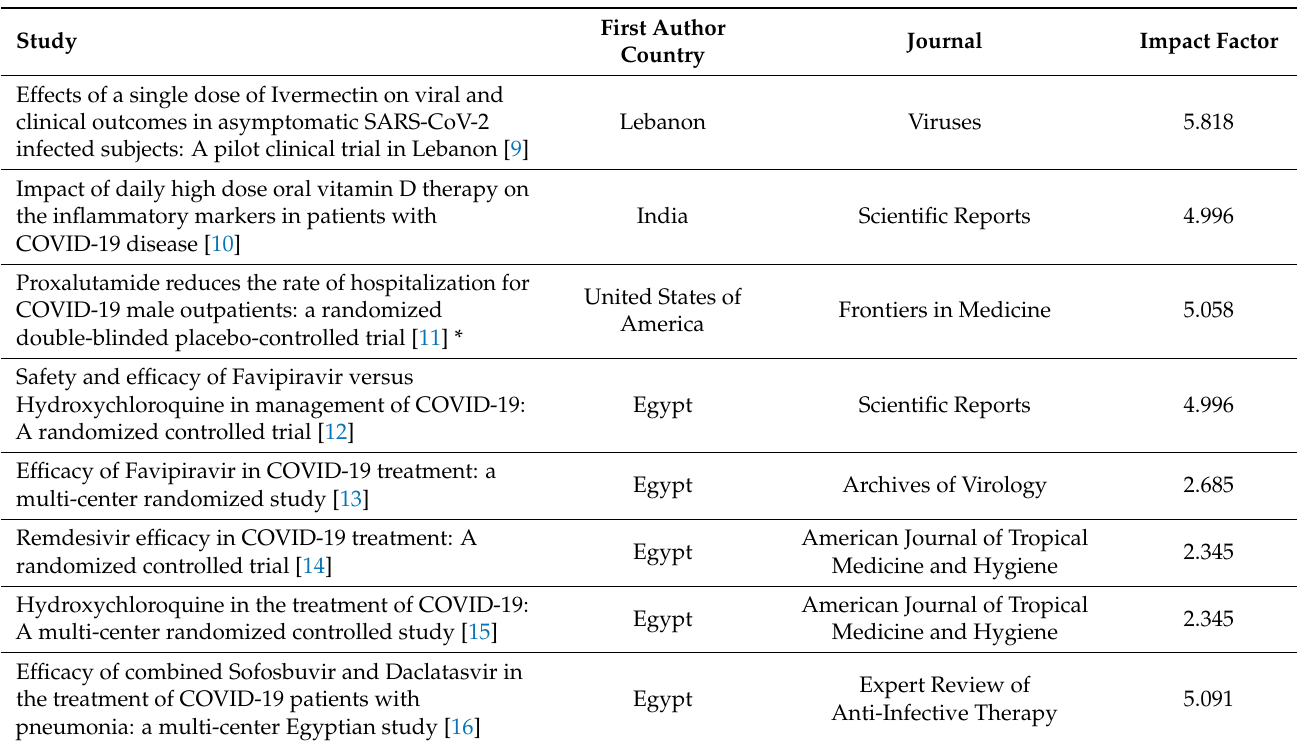
Table 2. Title of the retracted studies, first author’s country, and journal where the study was